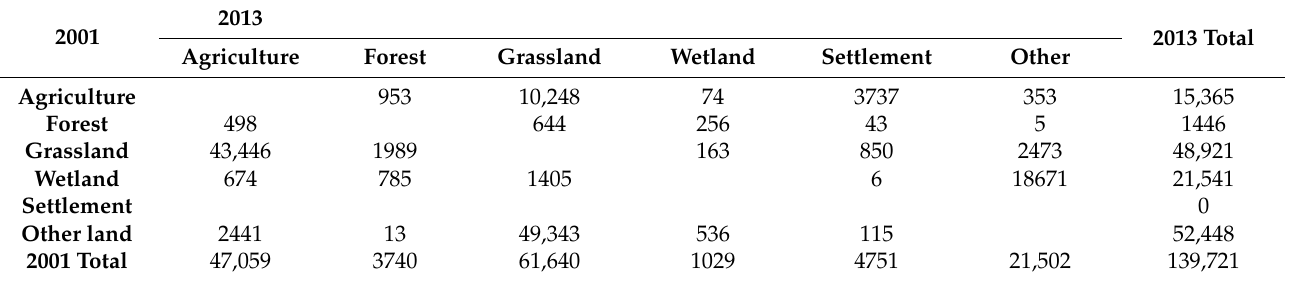
Table 4. LUCC conversion matrix in the CANs from 2001 to 2013 (unit: km 2 ).